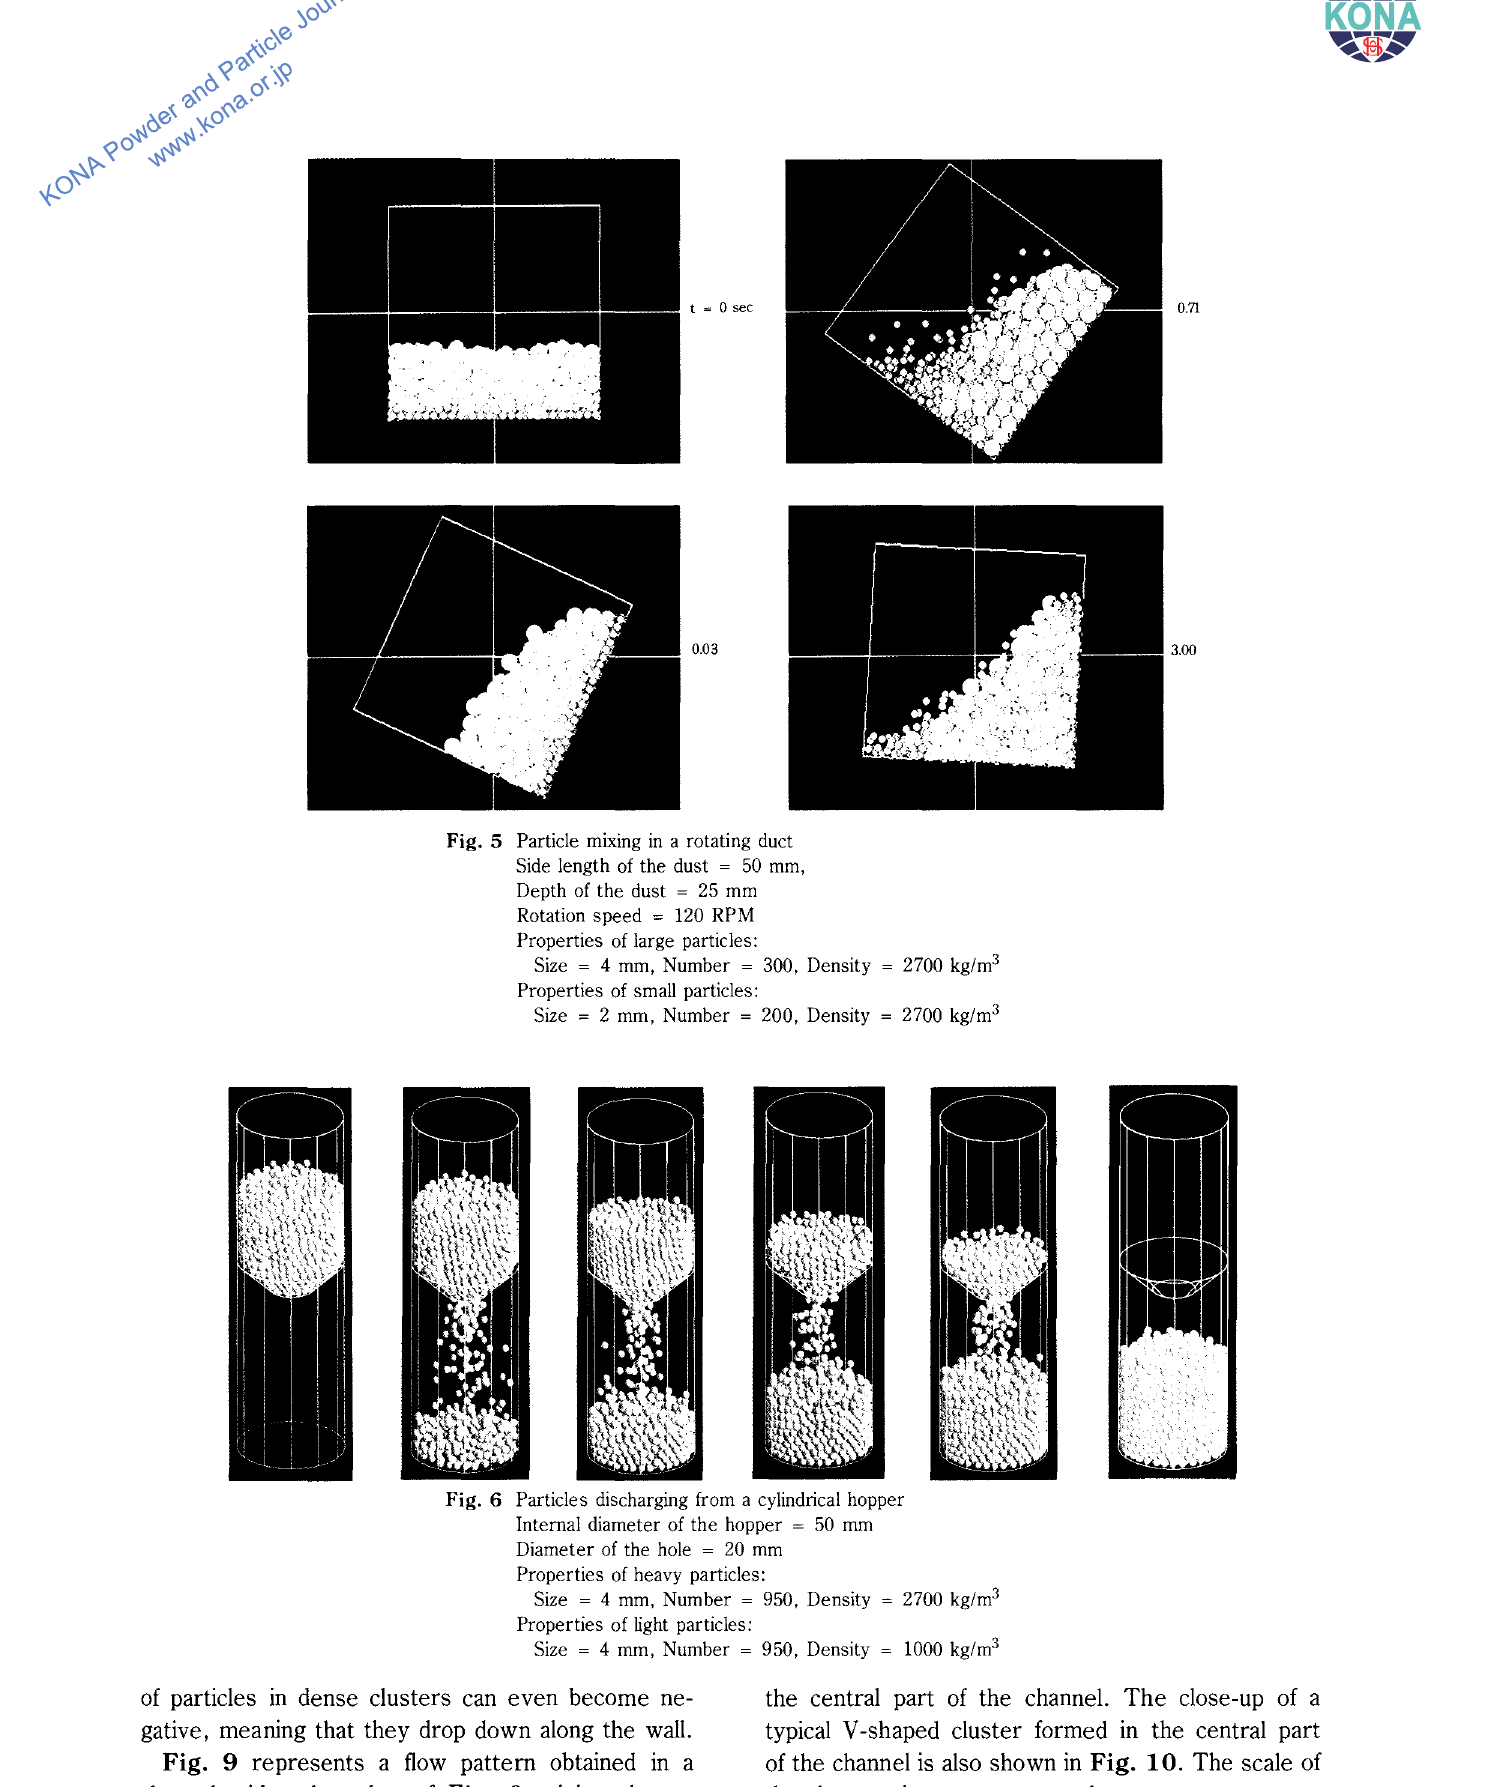
Fig. 6 Particles discharging from a cylindrical hopper Internal diameter of the hopper = 50 mm Diameter of the hole = 20 mm Properties of heavy particles: Size = 4 mm, Number = 950, Density = 2700 kg/m 3 Properties of light particles: Size = 4 mm, Number = 950, Density = 1000 kg/m